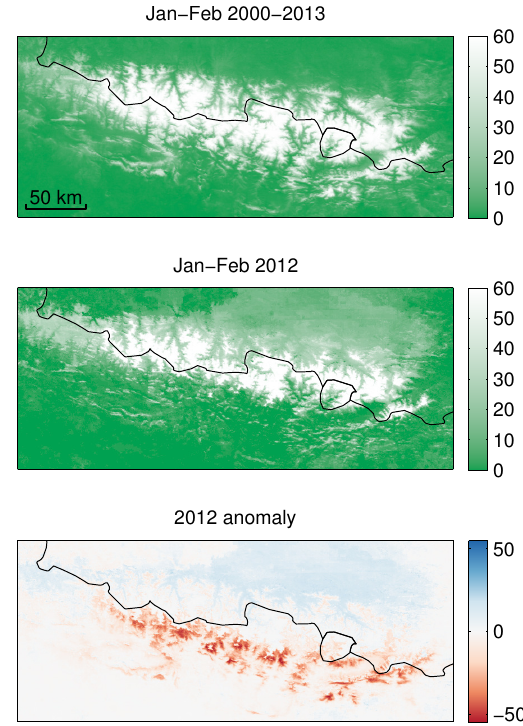
Figure 13. Illustration of the anomalous snow patterns in the Pyre- nees during the 2012 winter. Top panel: mean snow cover duration (days) in January and February. Middle panel: snow cover duration in January and February 2012. Bottom panel: snow cover duration